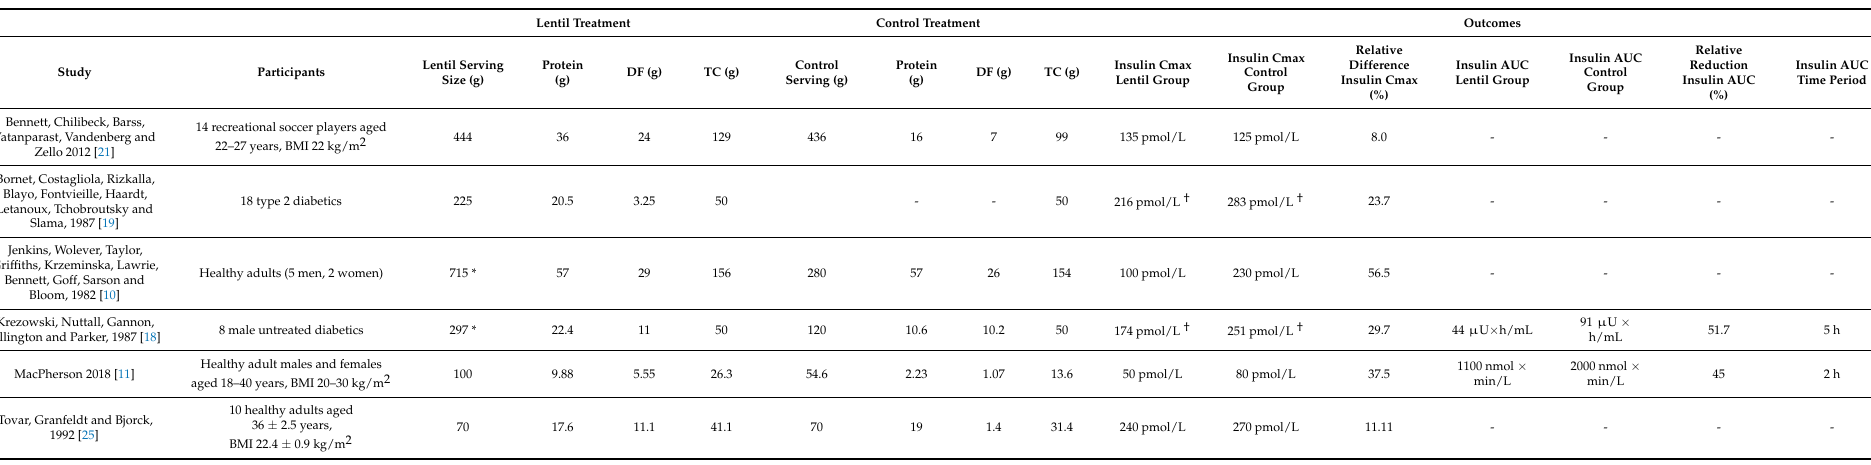
DF, Dietary Fibre; TC, Total Carbohydrates; AUC, area under the curve. * Raw weights provided by these studies were converted to cooked weights using the average moisture content of green lentils (68.4%), as gathered from previous research (unpublished data). The cooked weight was calculated as follows: (dry weight/% solids) × 100, where % solid = 100–68.4. † Insulin Cmax values were converted from µ U/mL to pmol/L using the conversion factor 1 µ U/mL = 6 pmol/L (Diabetes Care 1998). mU/mL was converted to pmol/L using the conversion factor of 1mU/L = 6 pmol/L (Vølund 1993). (Krezowski et al. provided an original value of 10.5 µ U/mL and 23 µ U/mL. for lentil and control treatments, respectively. Bornet et al. gave an original value of 25 mU/L and 42 mU/L for lentil and control treatments,